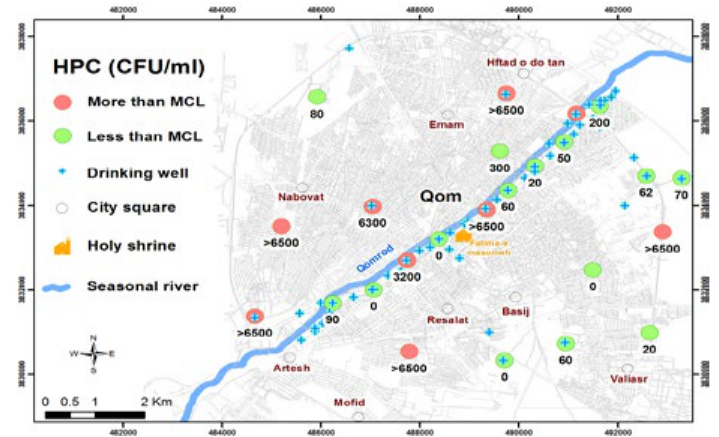
Fig. 9: Groundwater pollutants in Qom urban areas Fig. 8. Groundwater HPC index in Qom urban areas